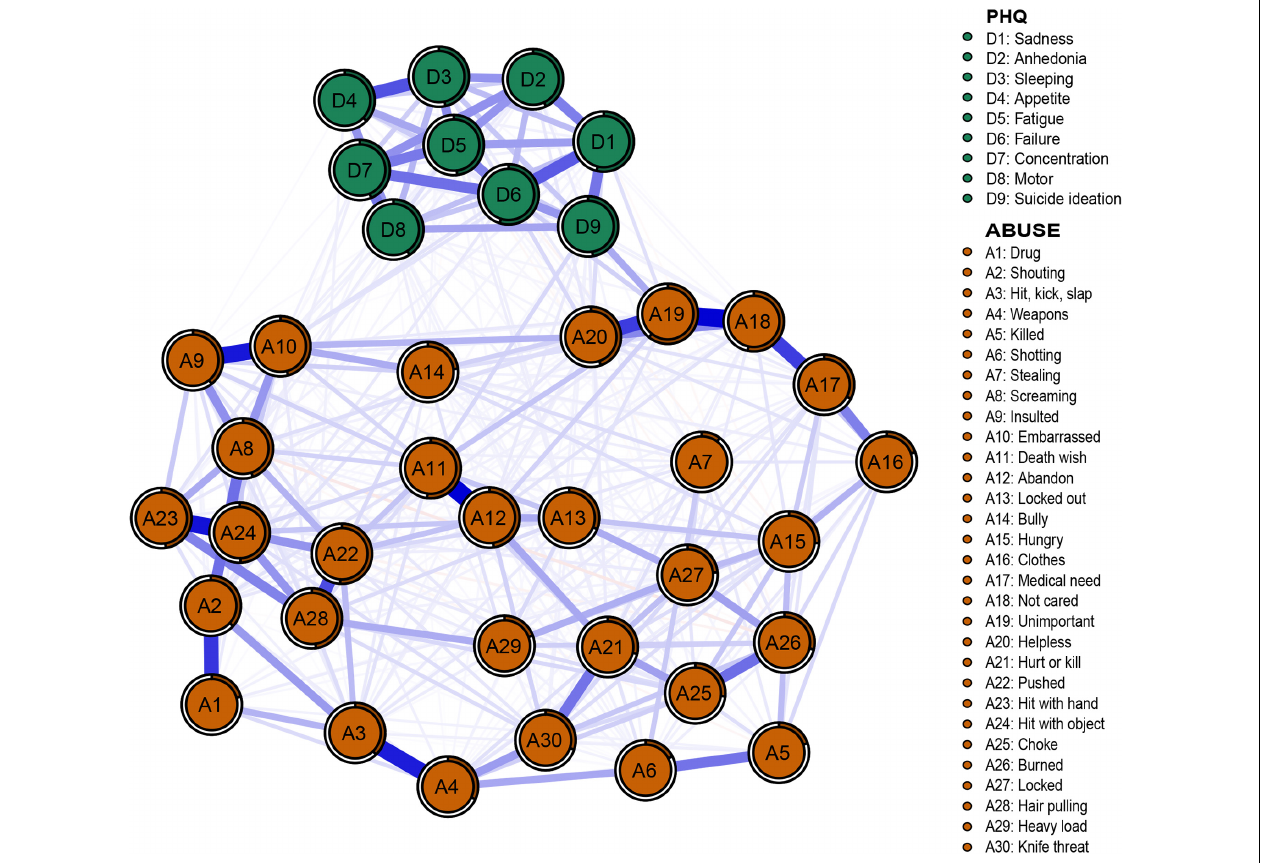
FIGURE 2 | Network structure of abuse events and depression symptoms in